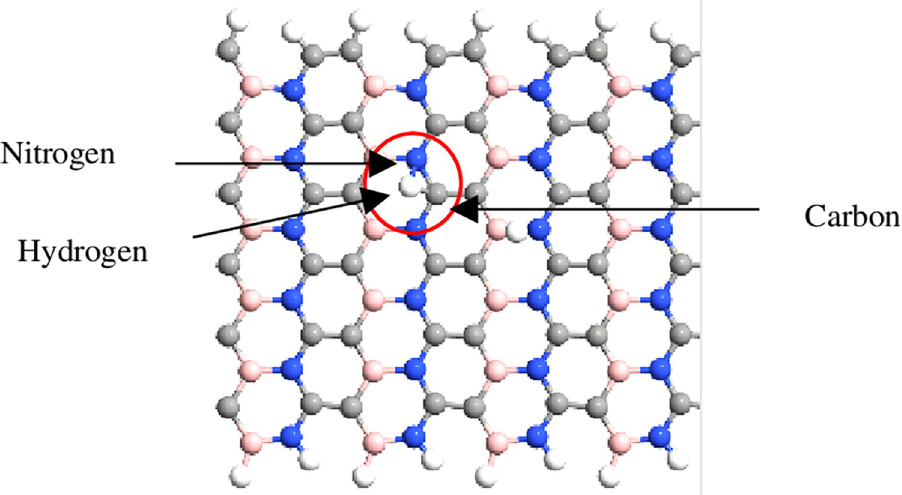
Fig 7. Optimized structures of 12-BC 2 NNR with multiple H 2 gas molecules in different positions at carbon and nitrogen